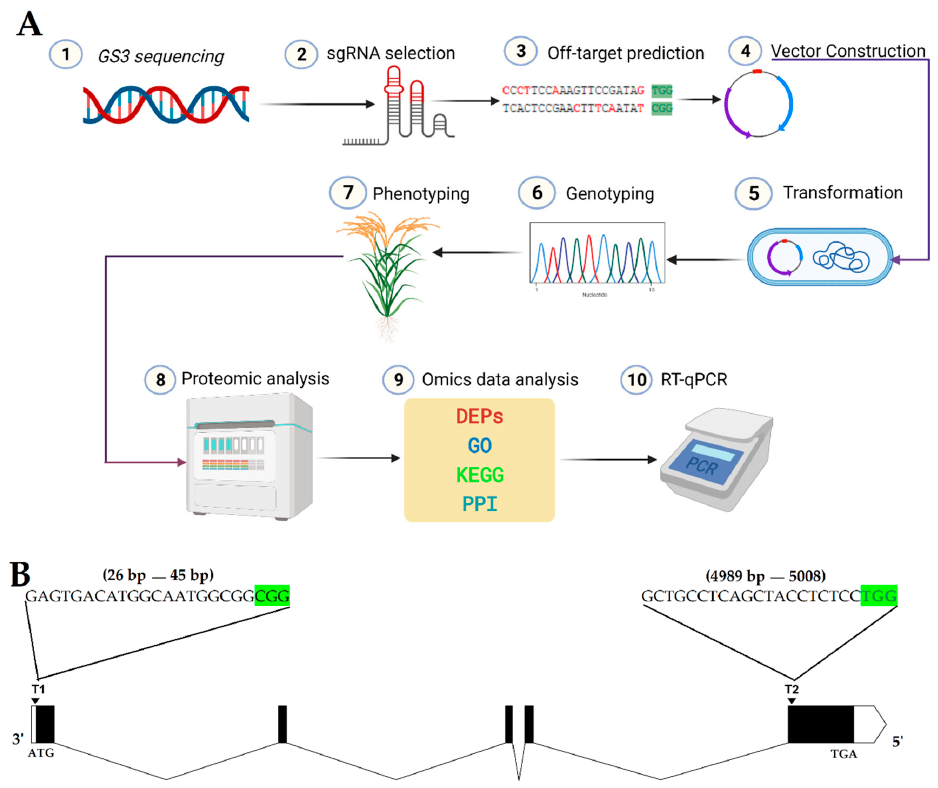
Figure 8. ( A ) Schematic diagram of the procedure for CRISPR/Cas9-based generation of mutant plants and analysis of mutations. Two sgRNAs were selected using the CRISPR-GE online web-based tool, and vector was constructed. Agro- bacterium-mediated transformation was performed, and T 0 plants were regenerated. Later generations were produced by self-pollination, and genotyping was performed using target-specific primers. The phenotypic data of mutant and wild-type (WT) plants were recorded and further analyzed. The proteomic analysis was also performed, and RT-qPCR was performed to assess the GS3 expression level and validate the proteomic data. ( B ) Diagram of GS3 gene and positions of both target sites. ATG is the start codon; TGA is the stop codon; green highlighted CGG and TGG are the PAM se- quences; the white boxes at extreme left and right represent the untranslated (UTR) regions, the black boxes represents the exons; black lines in between the exon regions represent the intron regions, T1 and T2 represent target 1 and target 2, respectively.